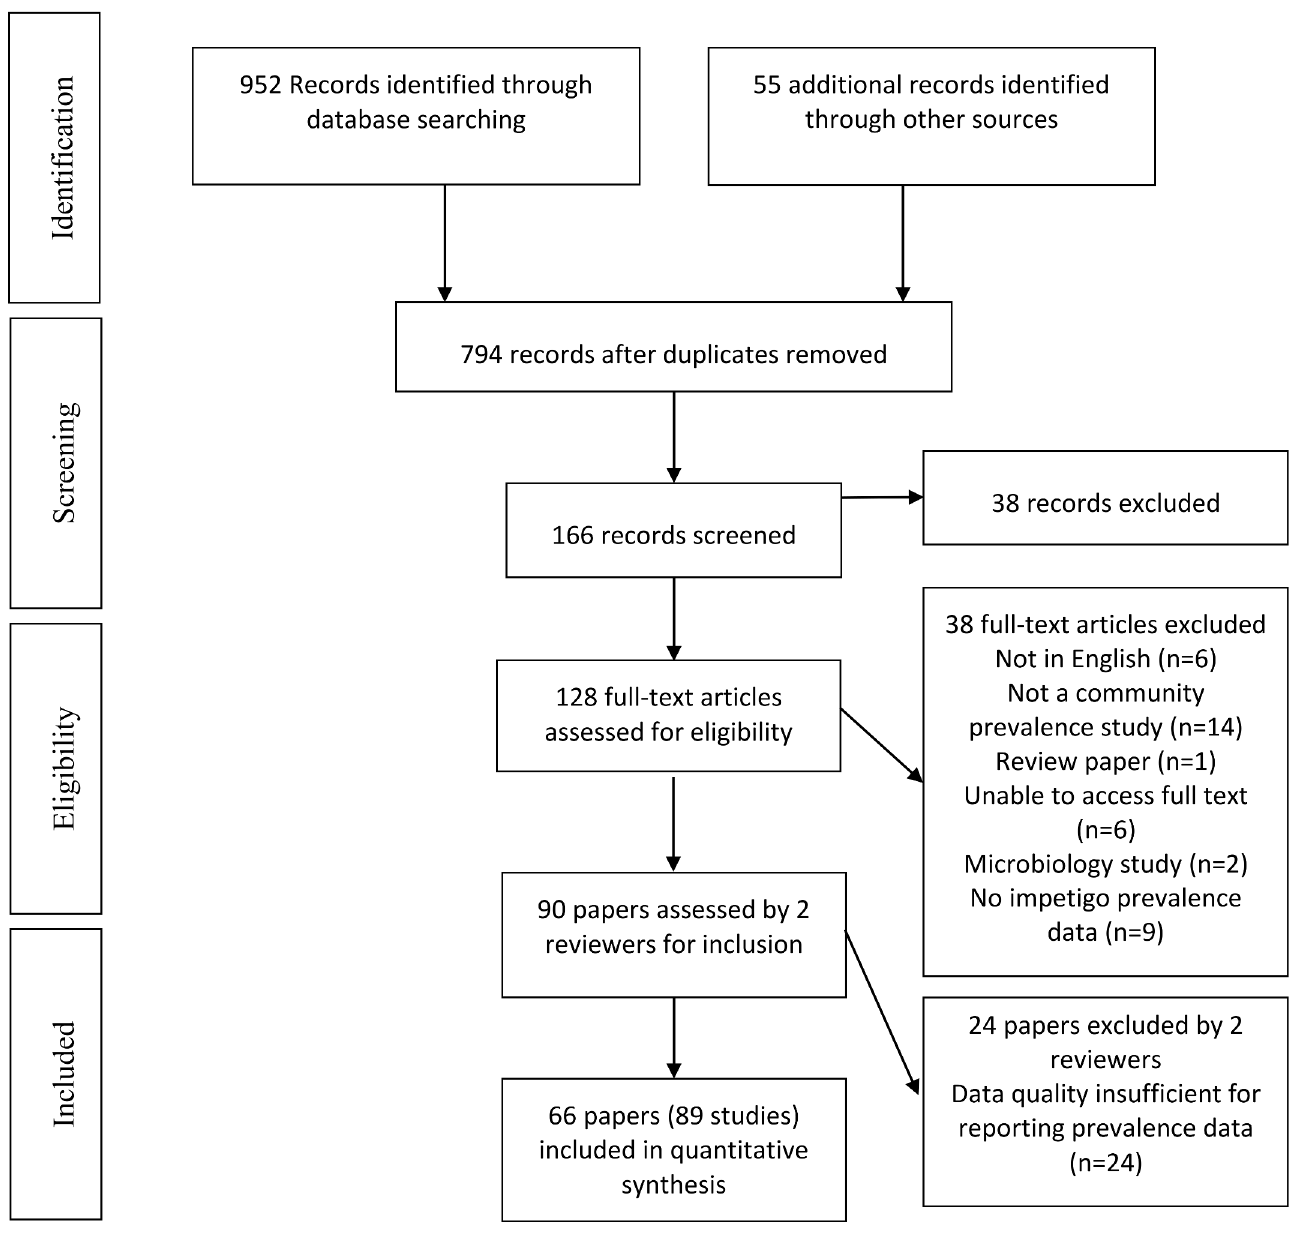
Fig 1. Flowchart of systematic review according to the PRISMA